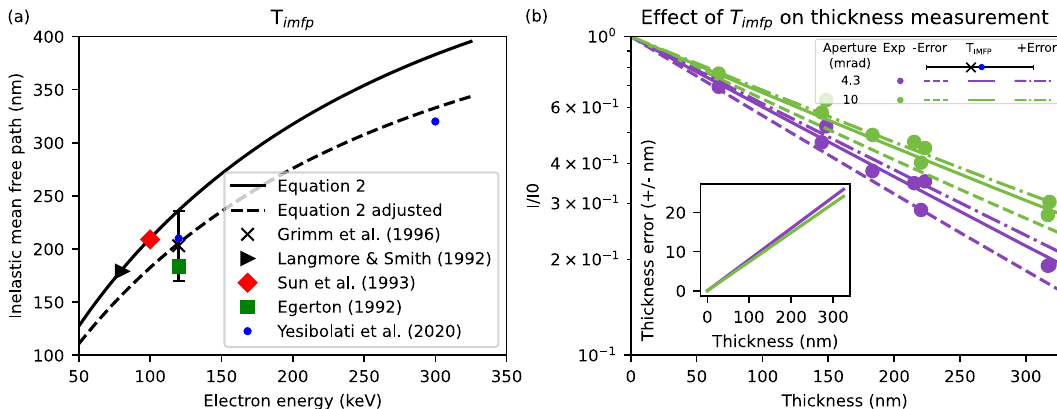
Fig. 5 Variance in measurements of inelastic mean free path and its impacts on MeasureIce. a Literature values for experimental mean free path plotted alongside Eq. 2, and the interpolating function for mean free paths used in MeasureIce (Eq. 2 adjusted). b Ice thickness measurement errors that would be implied by the effect of experimental errors from Grimm et al. 24 . Solid line is the calibration curve implied by Yesibolati ’ s mean free path measurement at 120 kV 21 and the dashed lines represent the extremities of the error bars in ( a ), the plot inset is the error as a function of thickness implied by Yesibolati ’ s